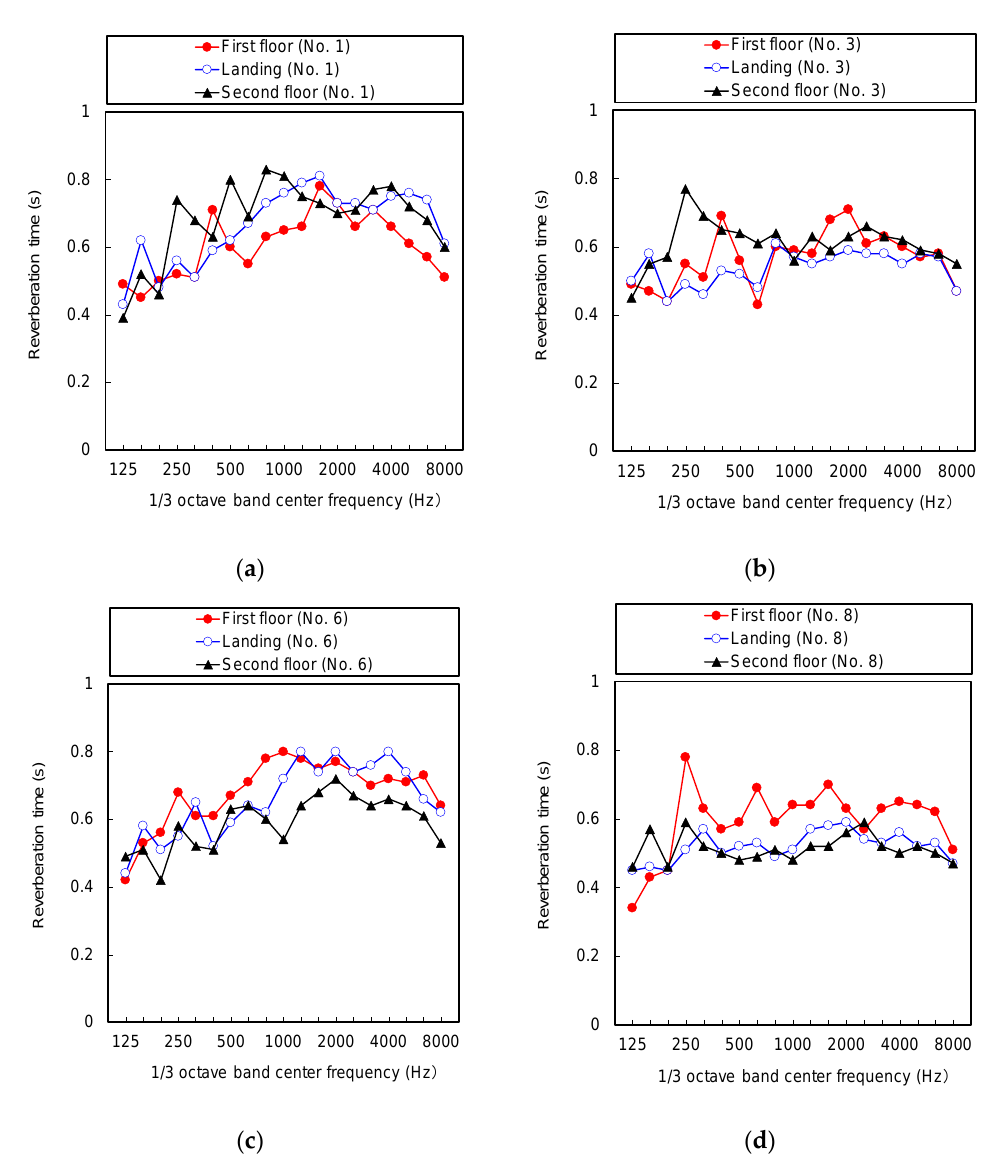
Figure 10. Measurement results on reverberation time of the sound absorption panel installation. ( a , c ) Sound source position: first floor; ( b , d ) Sound source position: second